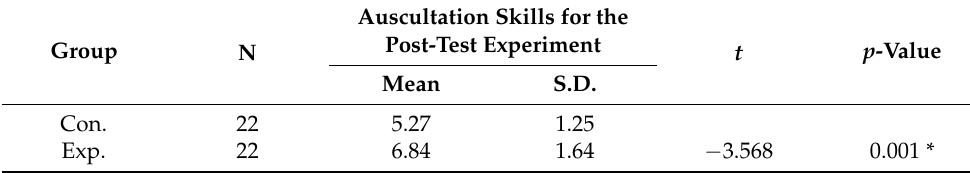
Table 4. The Independent t -test statistical results in a post-test experiment of both groups.